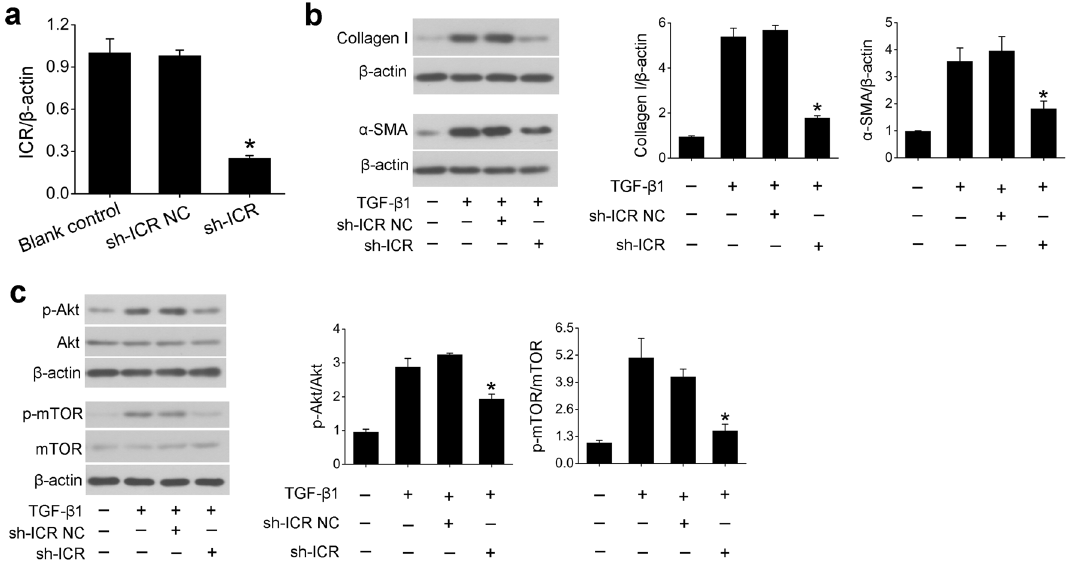
Figure 4. ICR downregulation attenuates fibrotic changes and inhibits phosphorylation of Akt and mTOR in TGF-β1-treated human proximal tubular HK-2 cells. ( a ) QPCR analysis normalized to β-actin showed a significant decrease in the level of ICR in HK-2 cells transfected with ICR shRNA plasmids (sh-ICR) compared with its negative control (sh-ICR NC). Knockdown of ICR upon transfection with sh-ICR plasmid significantly reduced both profibrotic protein levels of collagen I and α-SMA ( b ), and phosphorylation of Akt and mTOR ( c ) in HK-2 cells stimulated with TGF-β1 (10 ng/ml, 48 h). The protein levels of collagen I and α-SMA were normalized to β-actin; the phosphorylated Akt and mTOR were normalized to Akt and mTOR, respectively. The original blots are presented in Supplementary Figs. S2 and Fig. S3. Data are presented as means ± SD of three independent experiments. * P < 0.05, significantly different from negative control group (sh-ICR NC or TGF- β1 + sh-ICR